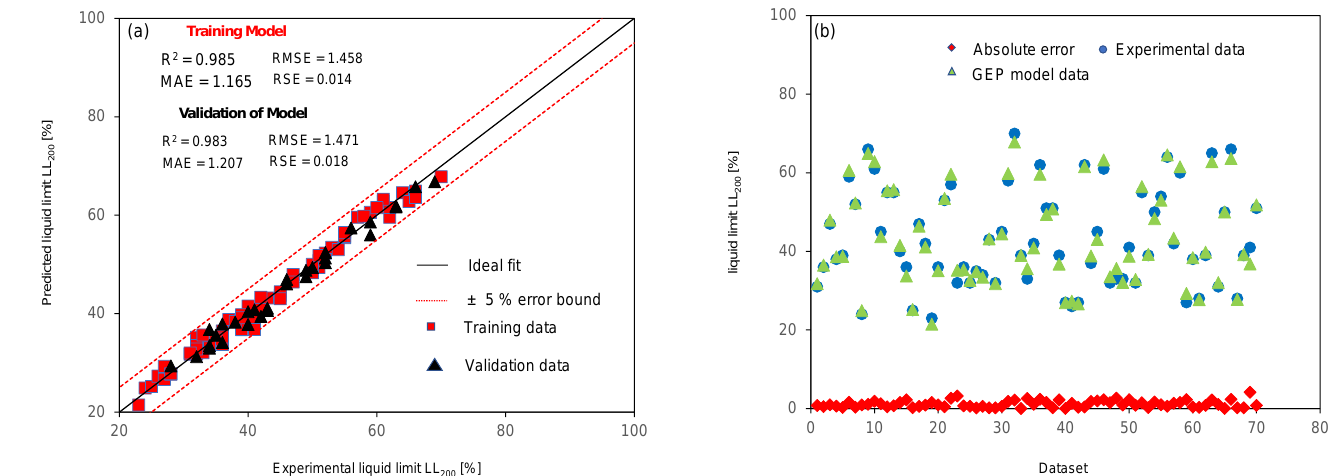
Figure 6. Performance evaluation of prediction model of LL 200 : ( a ) statistical analysis of proposed prediction model of LL 200 ; ( b ) comparison of GEP model responses, experimental data, and abso- lute error.